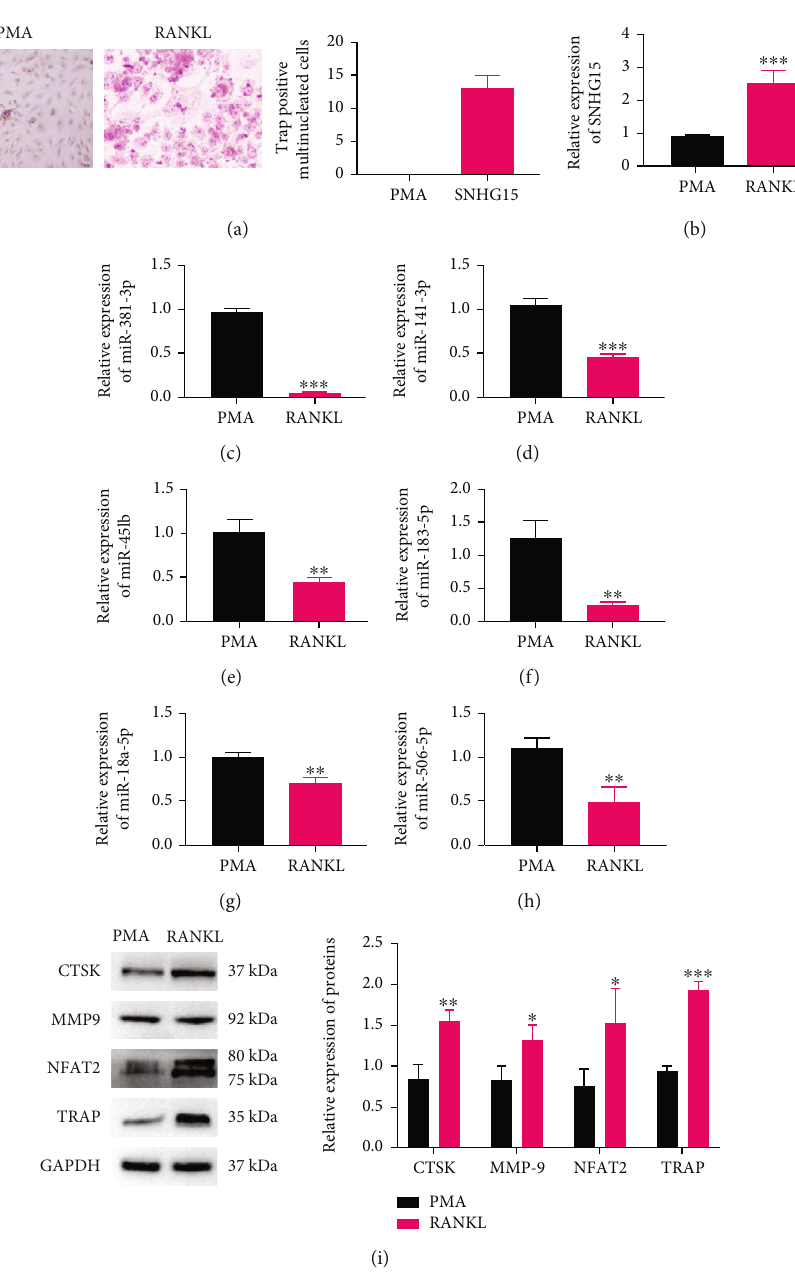
Figure 1: Induction of osteoclasts and the expression of lnc SNHG15 and miR-381-3p in osteoclasts. (a) TRAP staining observed osteoclast of THP-1 cells induced by RANKL; (b – h) RT-qPCR detected the expression of SNHG15, miR-381-3p, miR-141-3p, miR-451b, miR-183-5p, miR-18a-5p, and miR-506-5p; (i) Western blot detected the proteins expression of osteoclast markers CTSK, MMP-9, NFAT2, and TRAP. Compared with PMA group: ∗ P < 0 : 05 , ∗∗ P < 0 : 01 , and ∗∗∗ P < 0 : 001